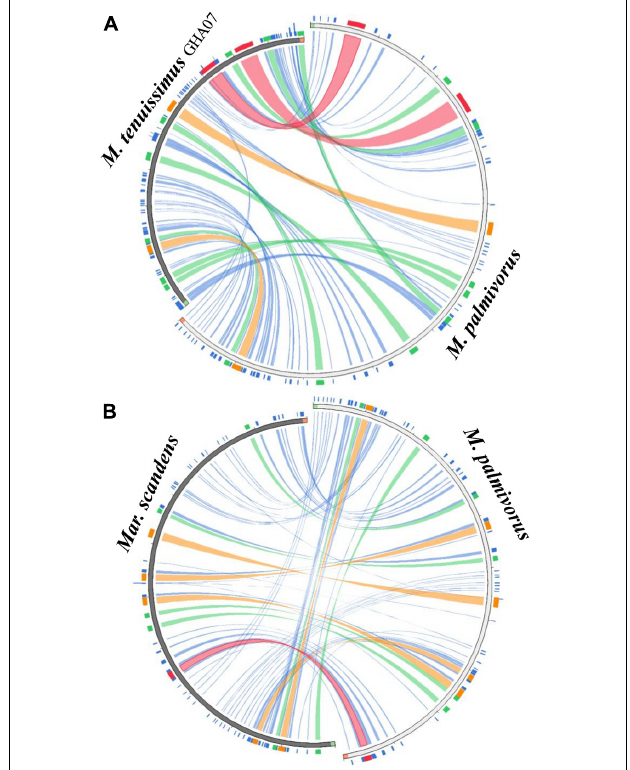
FIGURE 2 | Circos plot mapping the block rearrangements, synteny and identity level of (A) Marasmius tenuissimus and (B) Marasmiellus scandens against Marasmius palmivorus mitogenomes. Green and red block in the beginning and end of the sequences indicate the sequence orientation. Colors blocks and ribbons represent the local alignments produced by BLAST the score/max bits core ratio, with blue ≤ 0.25, green ≤ 0.50, orange ≤ 0.75, and red > 0.75 being the best quartile. The figure was produced using Circoletto (Darzentas, 2010).